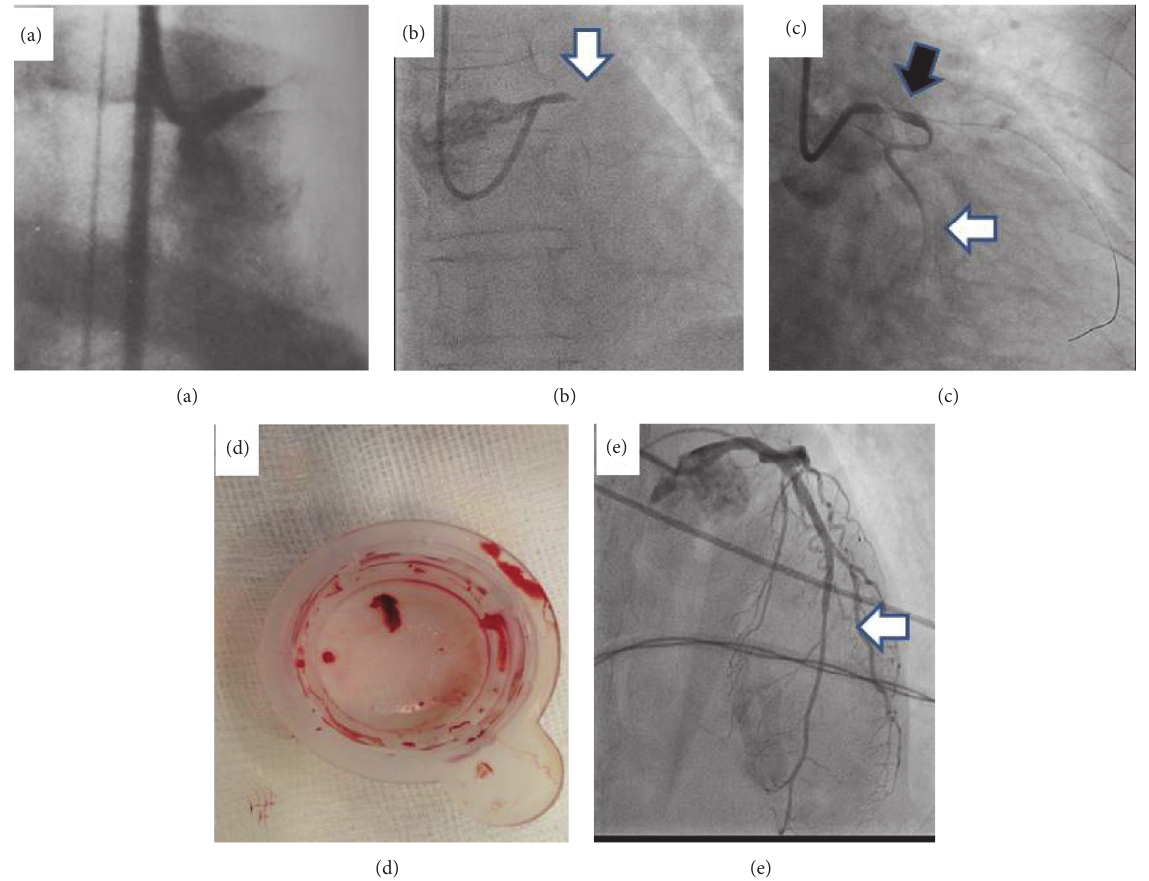
Figure 1: (a) Coronary angiography of patient number 1, catheterized 15 days after arrival showing complete occlusion of the left main coronary artery. Note femoral approach (published with permission from Elsevier), (b) patient number 2 coronary angiography showing completeocclusionoftheleftmaincoronaryartery(whitearrow),(c)afterpassingaguidewiredowntheleftmainandleftanteriordescending arteries the circumflex coronary artery was demonstrated (white arrow); left main coronary artery filling defect is demonstrated (black arrow), (d) thrombus aspirated from the left main prior to angioplasty, and (e) patient left main and left anterior descending coronary arteries demonstrated during the second catheterization, three days after